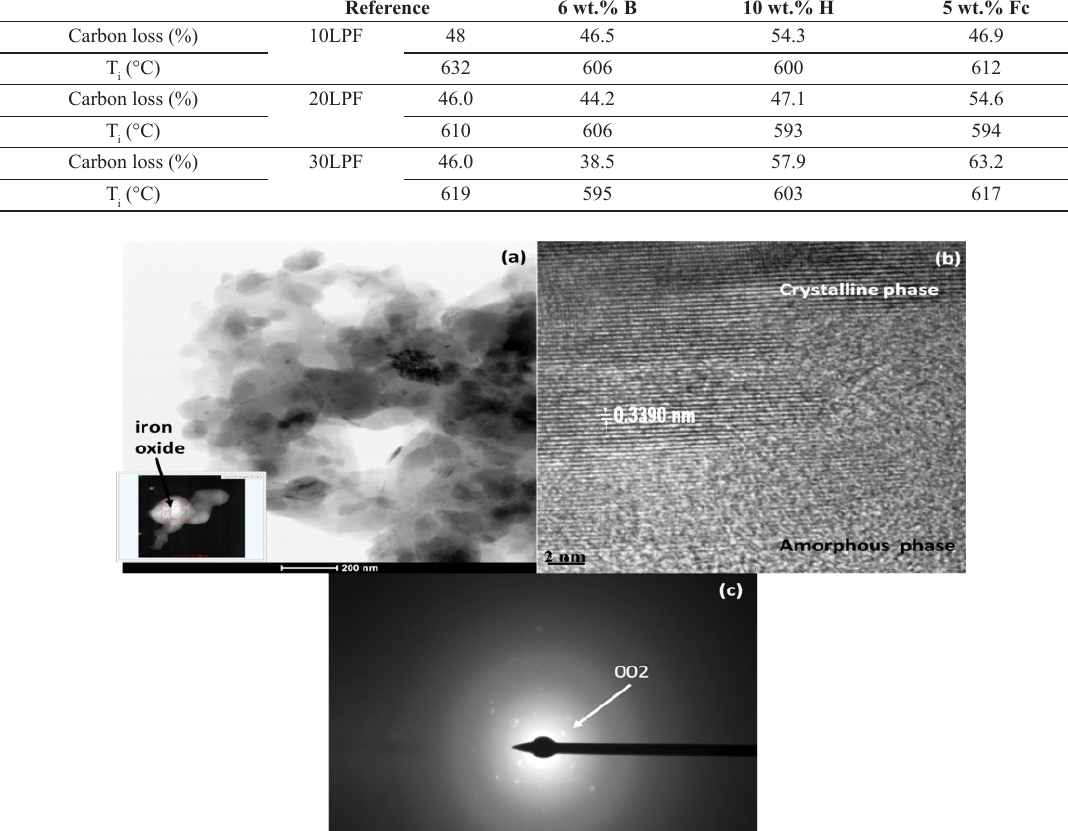
Table 7. Oxidation resistance of carbons derived the lignin-phenol-formaldehyde resins. Reference